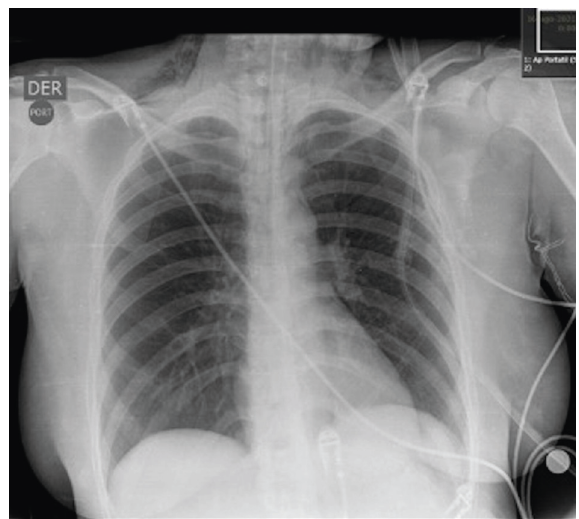
Figure 1: Chest X-ray: emphysema is observed in the cervical region, the cardiothoracic index was within normal limits, and no rib fractures, pneumothorax, or pleural effusion are identified, without consolidations or interstitial infiltrate.